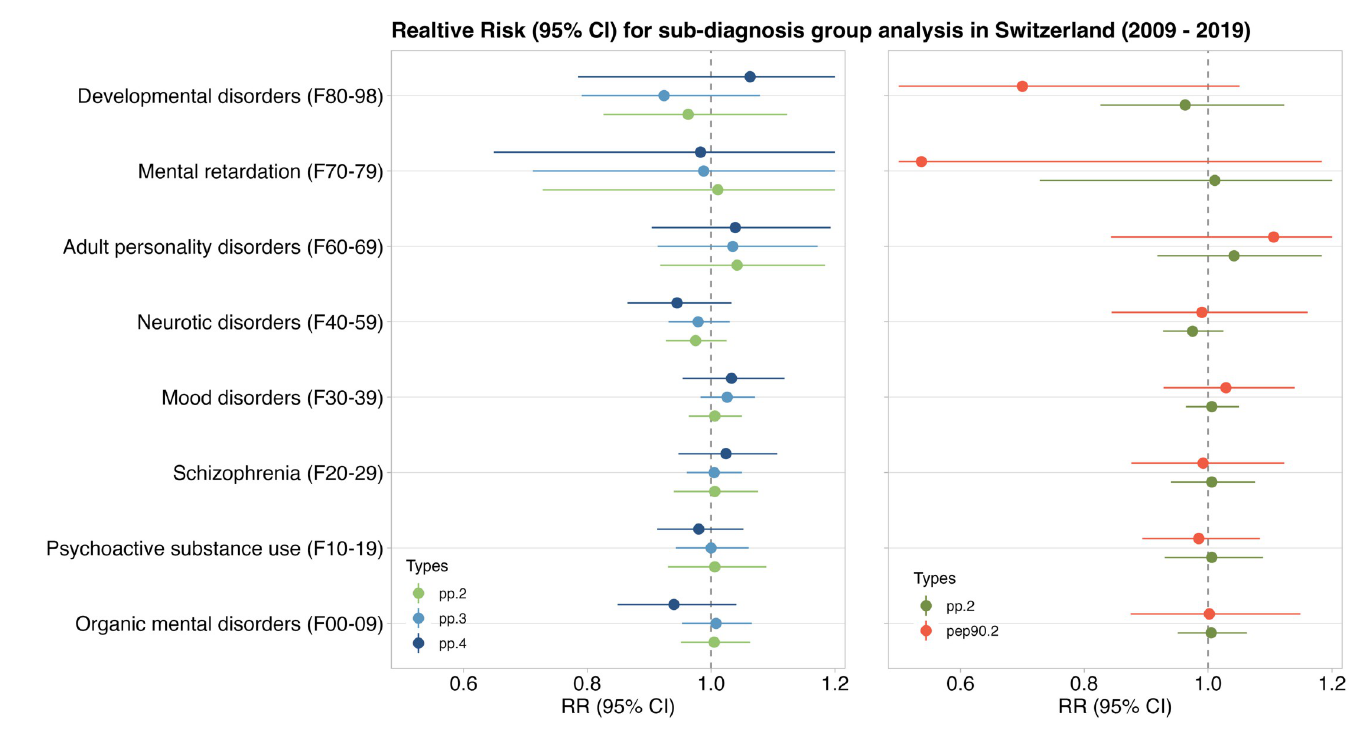
Fig 3. Pooled association estimates of sub-diagnosis group analysis between hospital admissions due to mental disorders and PP.2 PP.3, PP.4, and PEP90.2 events with lag 3 (Relative Risk [95% confidence interval]). It is represented in the perspective of duration (PP.2 vs PP.3 vs PP.4, left side) and the intensity (PP.2 vs PEP90.2, right side).